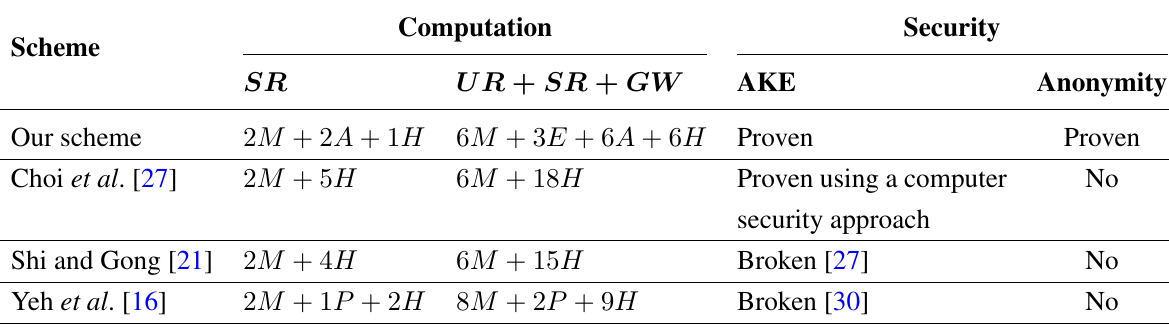
Table 3. A comparison of elliptic curve cryptography (ECC)-based SUA - WSN schemes. AKE, authenticated key